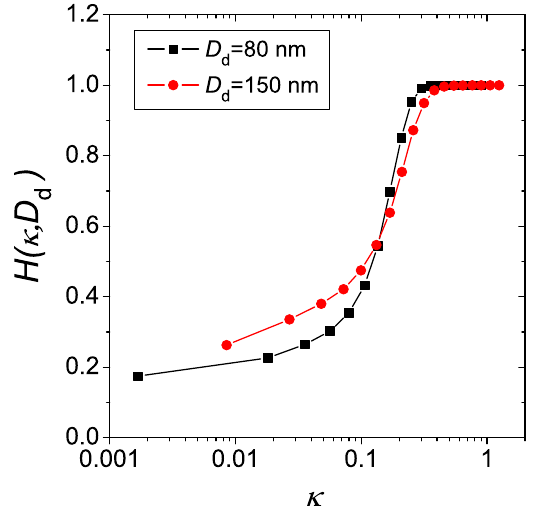
Fig. 1. Cumulative particle hygroscopicity distributions H(κ,D d ) calculated from exemplary HTDMA measurements performed in Beijing (one-day average for 12 June 2004). The dry particle diameters selected by the first DMA were 80nm and 150nm, further details can be found in the work of Massling et al. (2009).